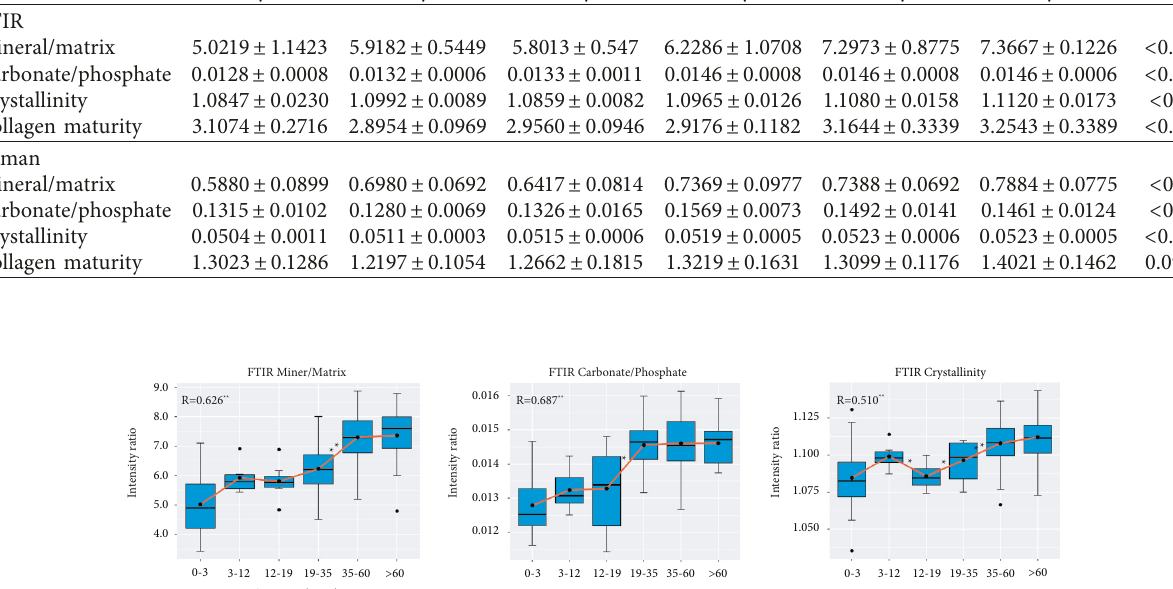
Table 2: FTIR and Raman statistical results in different age stage. The values are represented as mean test that failed to exhibit normal distributions or equal variance. And the rest are the results of single-factor ANOVA. Parameter